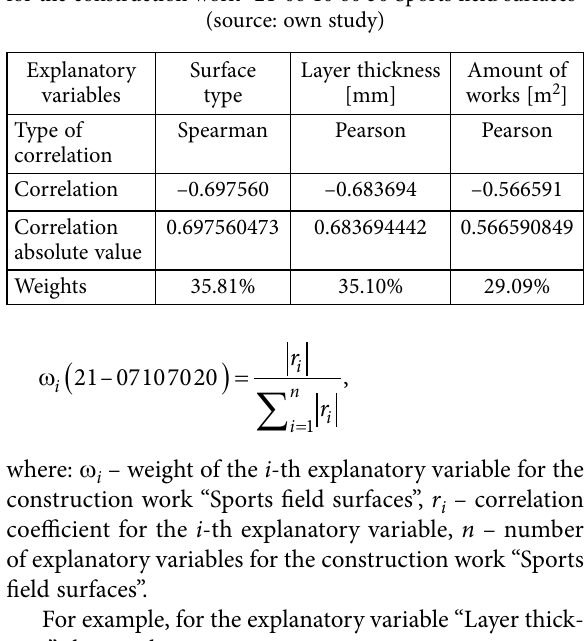
Table 6. Correlations and the weight of explanatory